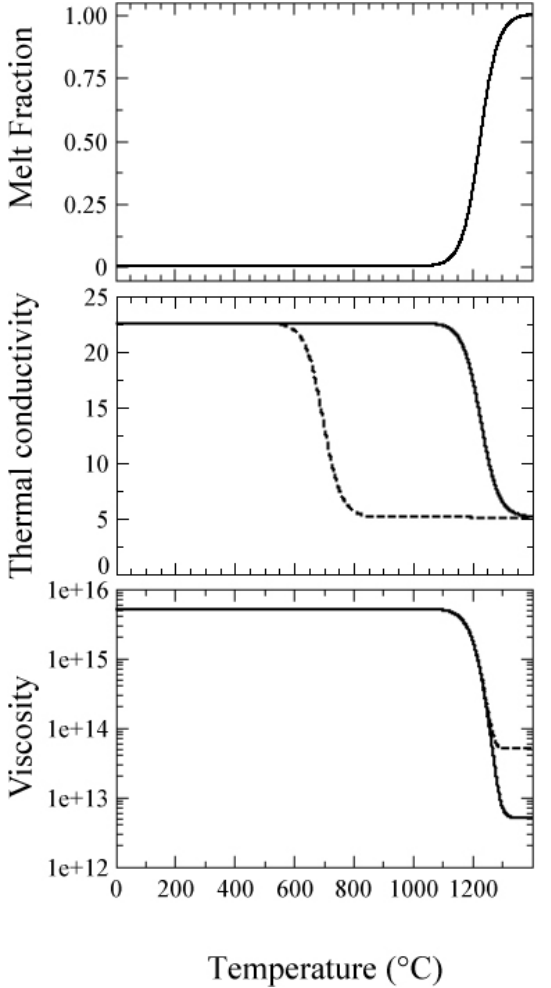
Fig. 2. Top: amplitude of the melt fraction 0 Cryst versus temper- Figure 2: top: Amplitude of the melt fraction  Cryst versus temperature; middle: 768 ature; middle: thermal conductivity k at the surface of the model thermal conductivity k at the surface of the model (dashed curve: T Crac =700°C; solid 769 (dashed curve: T Crac = 700 ◦ C; solid curve: T Crac = 1000 ◦ C); bot- curve: T Crac = 1000°C); bottom: dynamic viscosity  versus temperature (dashed curve: 770 tom: dynamic viscosity η versus temperature (dashed curve: η w =  w = 5.10 13 Pa.s, solid curve:  w = 5.10 12 Pa.s). 771 5 × 10 13 Pas, solid curve: η w = 510 12 772